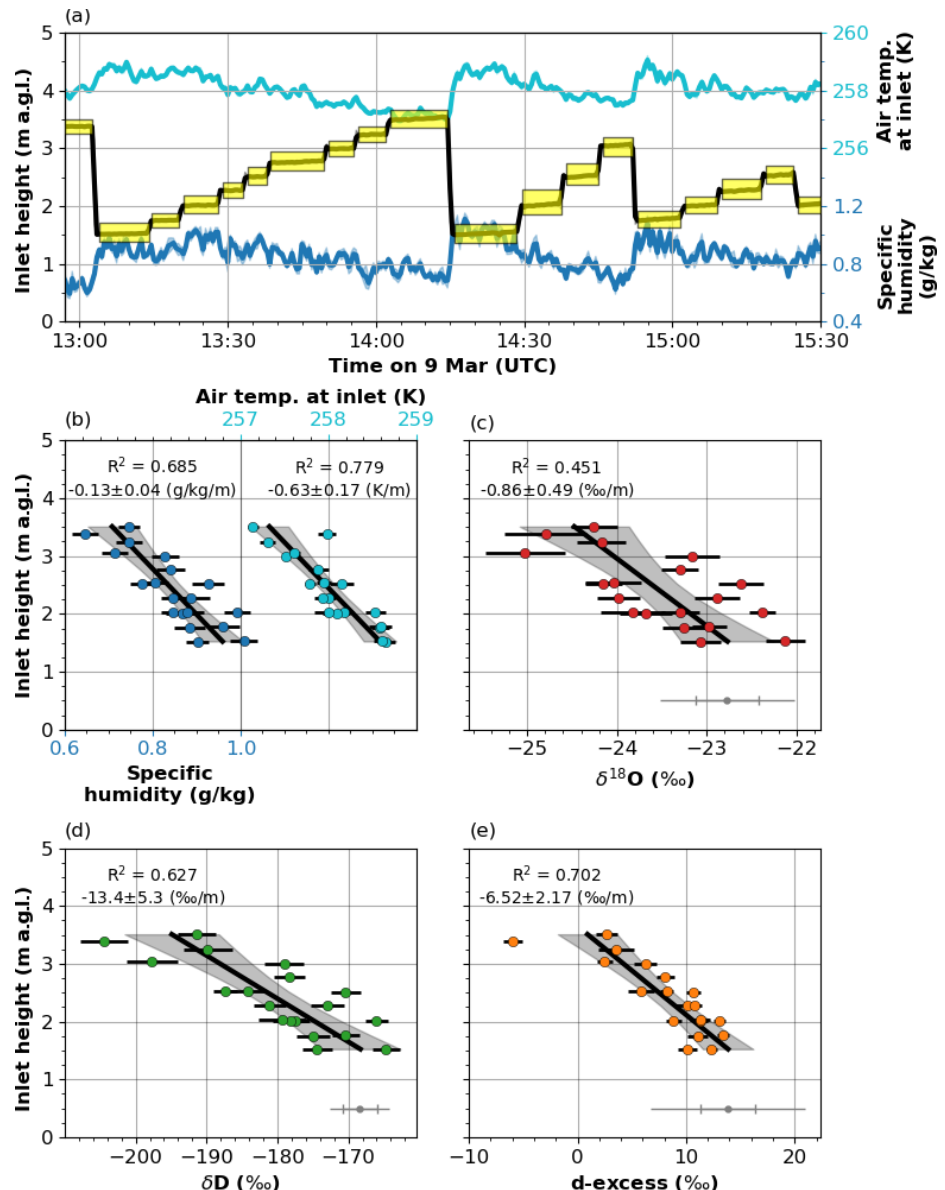
Figure 10. A profiling operation from 12:57 to 15:30UTC on 9 March 2020. (a) A time series of inlet head height (black lines, left axis), alongside the air temperature at the same (cyan line, upper-right axis) and specific humidity (blue line, lower-right axis). A total of 19 height levels and their durations are denoted with yellow highlighting. (b) Vertical profiles of the air temperature at the inlet head (cyan, upper-right axis) and specific humidity (blue, bottom-left axis). Error bars signify standard errors, with 99% confidence interval. Thick black line is the linear regression through the data points, with shading showing 95% confidence interval. (c) Same as panel (b) but for δ 18 O. (d) Same as panel (b) but for δ D. (e) Same as panel (b) but for d-excess. The lower gray marker and error bar is a variability scale denoting a representative standard deviation for any particular height, with system uncertainty, as calculated in Sect. 4.2, indicated as